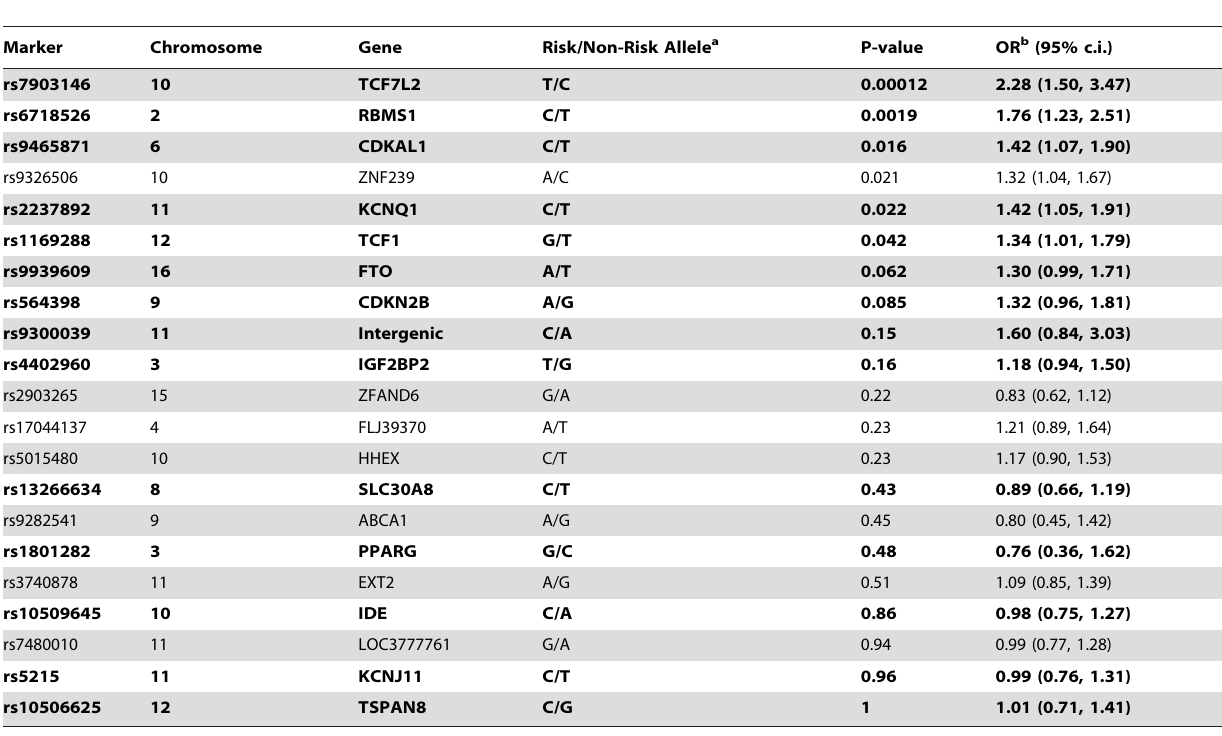
Table 1. Association test results for 21 candidate markers (accounting for SES, ancestry and BMI) in Antioquian T2D cases and